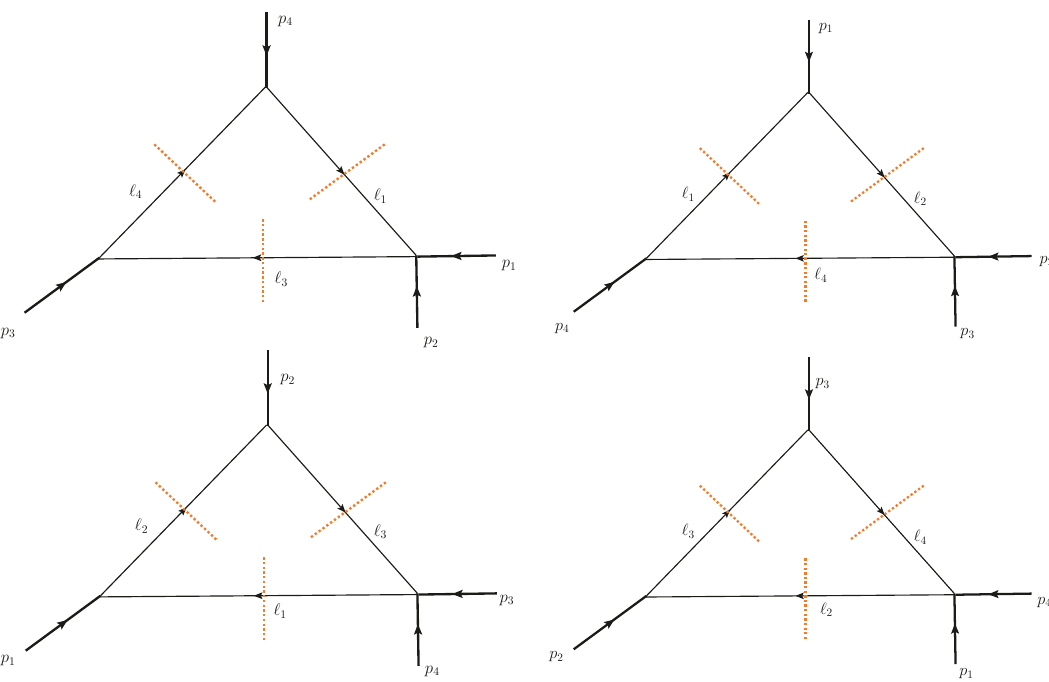
Figure 2 . Three-particle cut diagrams for the all-plus amplitude discussed in the text. Bold external lines represent physical gluons or gravitons, depending on the